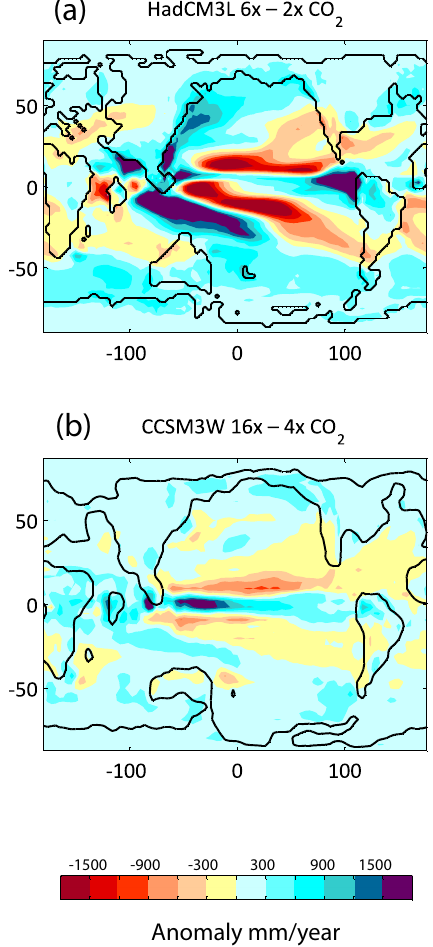
Figure 6. Anomaly plots for mean annual precipitation in millime- tres per year between high and low CO 2 . Eocene model simulations for (a) HadCM3L at x6 CO 2 –x2 CO 2 and (b) CCSM3 (W) at x16– x4 CO 2